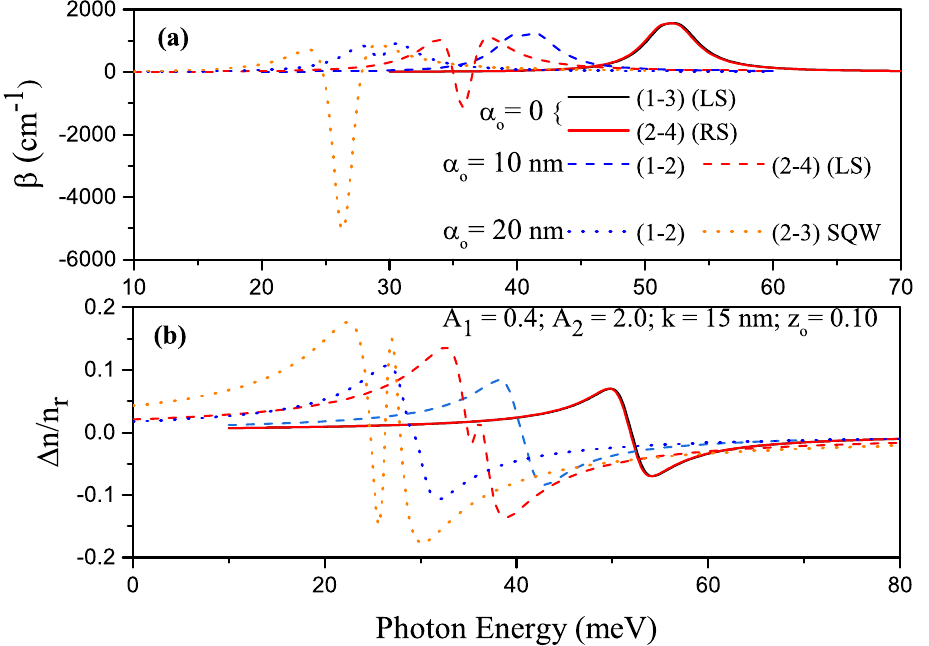
Figure 9. For some transitions in parabolic–Gaussian asymmetric DQW with k = 15nm, z o = 0.10, A 1 = 0.4 and A 2 = 2.0. ( a ) Variation in total absorption coefficients versus photon energy; ( b ) variation in total refractive index versus photon energy. Solid, dashed, and dotted curves are for α o = 0, α o = 10nm, and α o = 20nm,